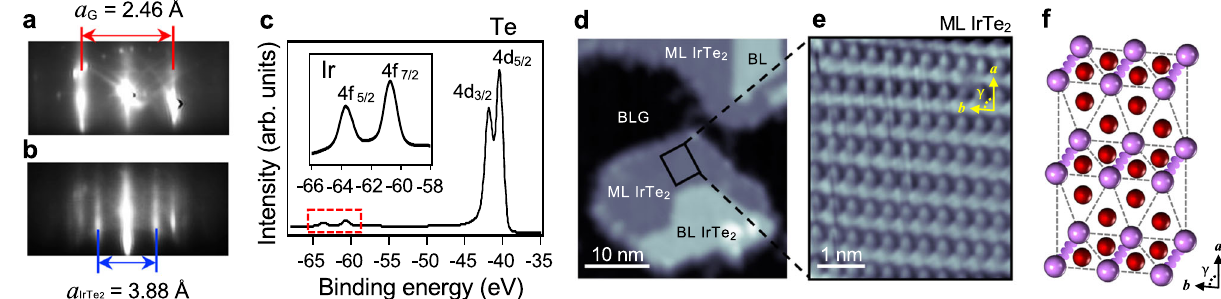
Fig. 1 Characterization of the epitaxial grown ML IrTe 2 . a , b RHEED images of a BLG substrate and b sub-ML IrTe 2 . c Core level spectra of ML IrTe 2 measured at 13 K using 110 eV photons. The inset is a close-up for the range marked by the red dashed box. d Typical STM topographic image of IrTe 2 on BLG substrate ( V s = 1.5 V, I 0 = 0.01 nA, T = 4.7 K). e Atomically-resolved STM image of ML IrTe 2 ( V s = 1 V, I 0 = 0.25 nA, T = 4.7 K). f Schematics of a top view of the distorted crystal structure of ML IrTe 2 . Purple and red balls represent Ir and Te atoms, respectively. Purple wavy lines represent dimerized Ir atoms.